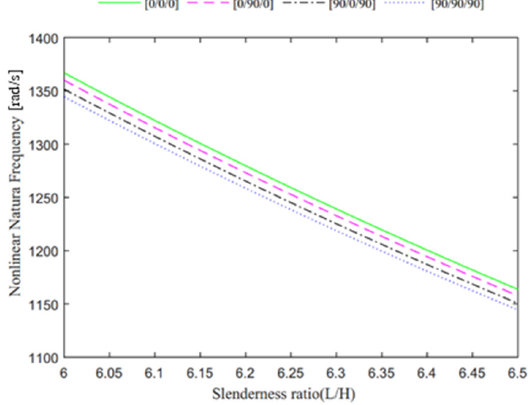
Figure 4. E ff ect of the uniform temperature rise on the nonlinear fundamental frequency. Figure 4. Effect of the uniform temperature rise on the nonlinear fundamental frequency.